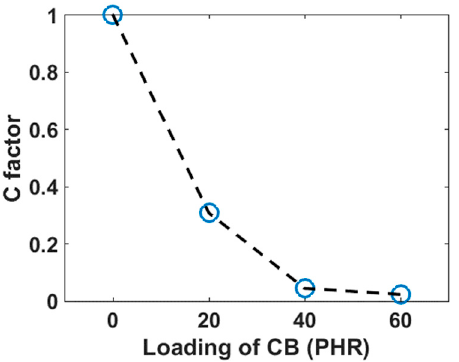
Figure 3. Variation of coefficient of reinforcement (C ‐ factor) with the proportion of CB